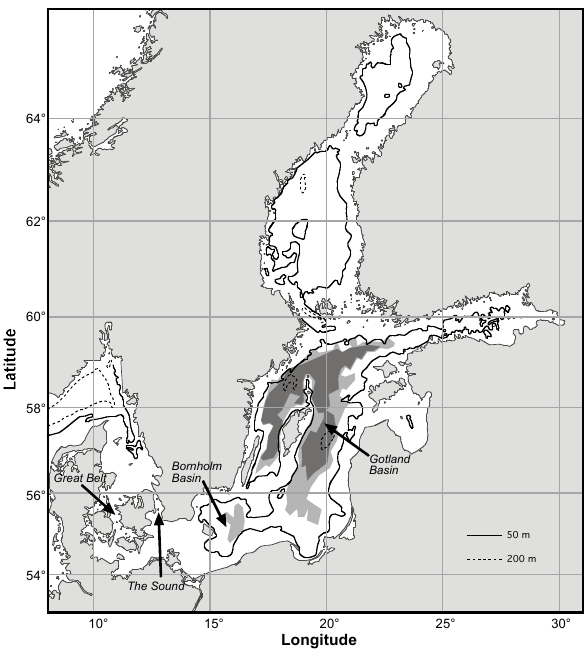
Fig. 4. Map of the Baltic Sea indicating the deep basins in the Baltic proper (Bornholm and Gotland basin). Given are the 50 and 200m depth contours. The shaded areas represent oxygen deficiency ( < 2mlO 2 L − 1 ) and anoxic (H 2 S) conditions in August 2008. Dark grey areas indicate hydrogen sulphide distribution with maximum of ca. 5mlH 2 SL − 1 .